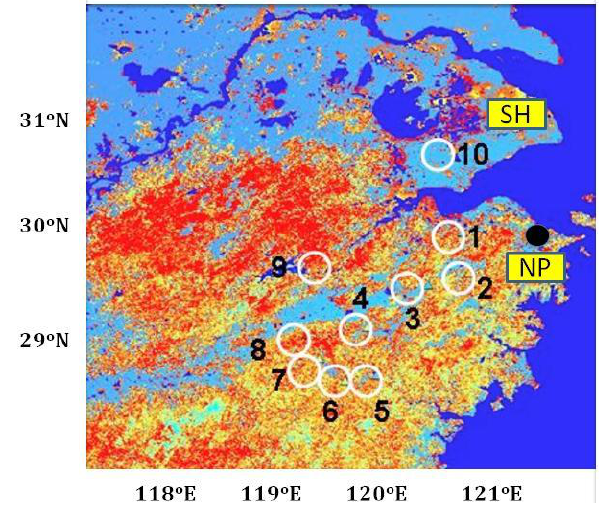
Fig. 1. MEGAN isoprene emission rates and measurement loca- tions in the forests south of